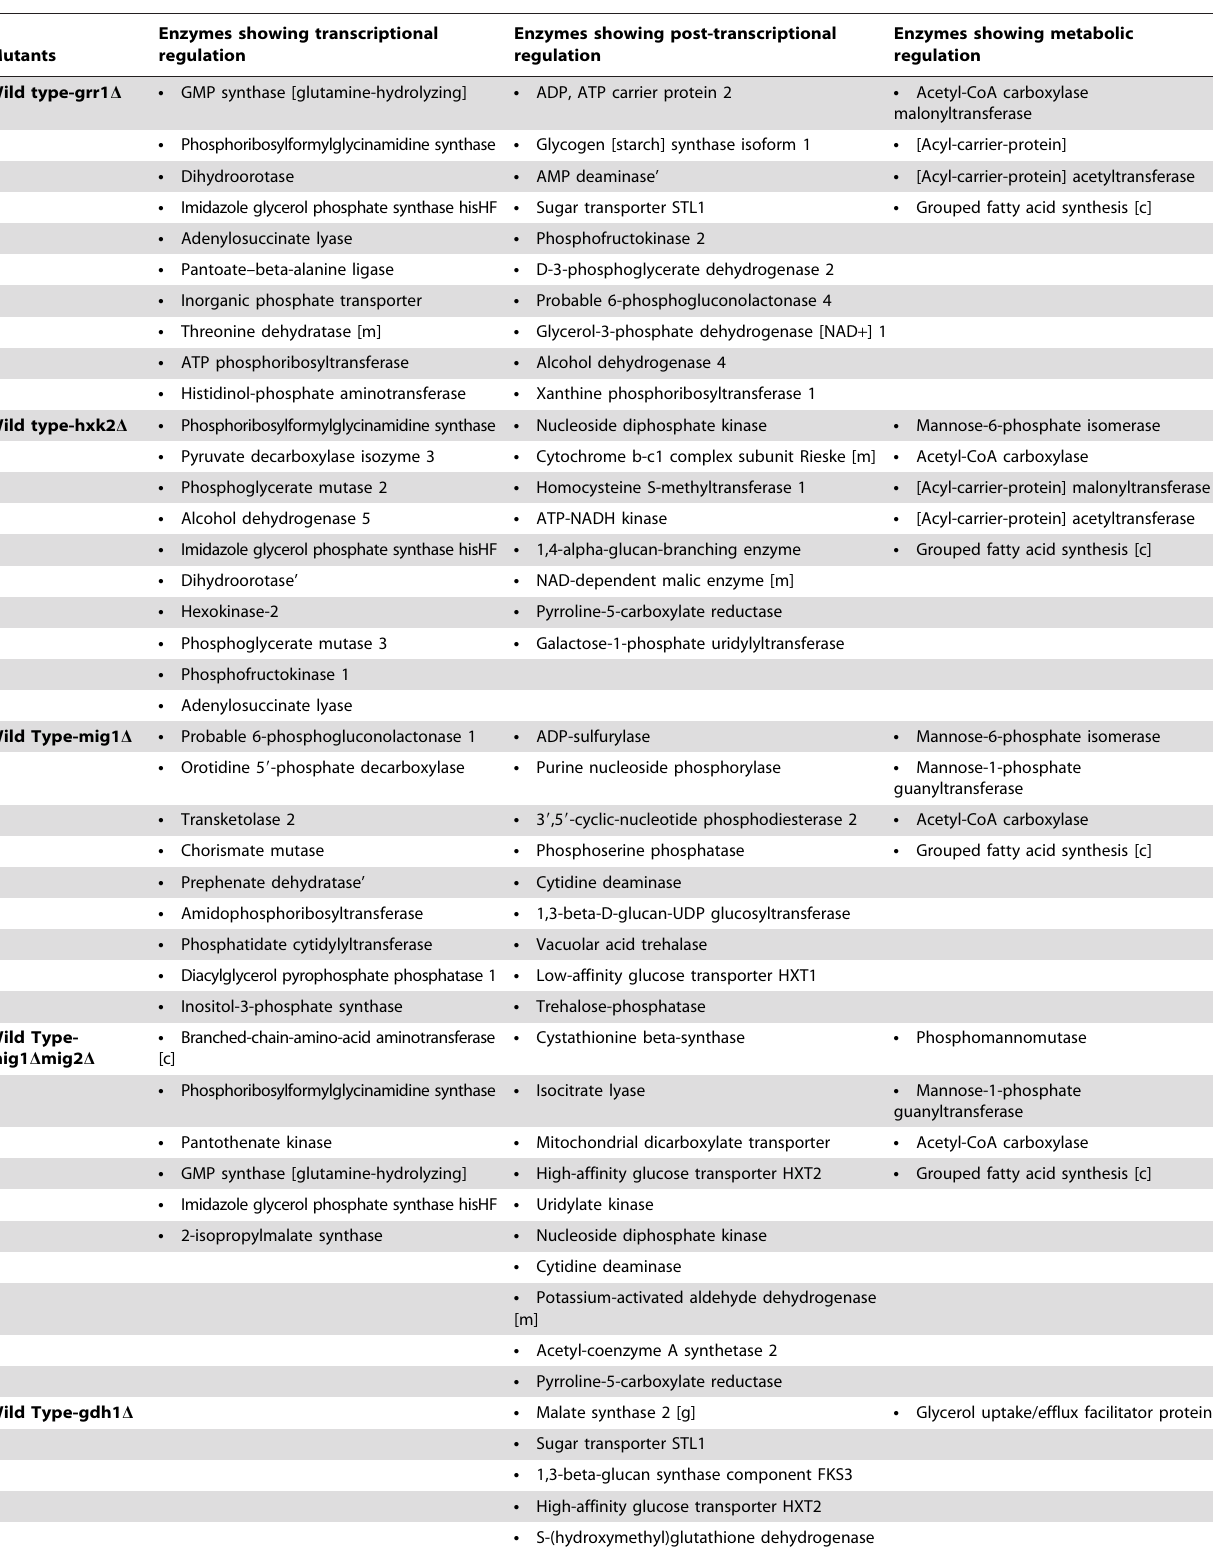
Table 3. Top scoring enzymes for transcriptional, post-transcriptional and metabolic regulation upon deletion of specific genes.